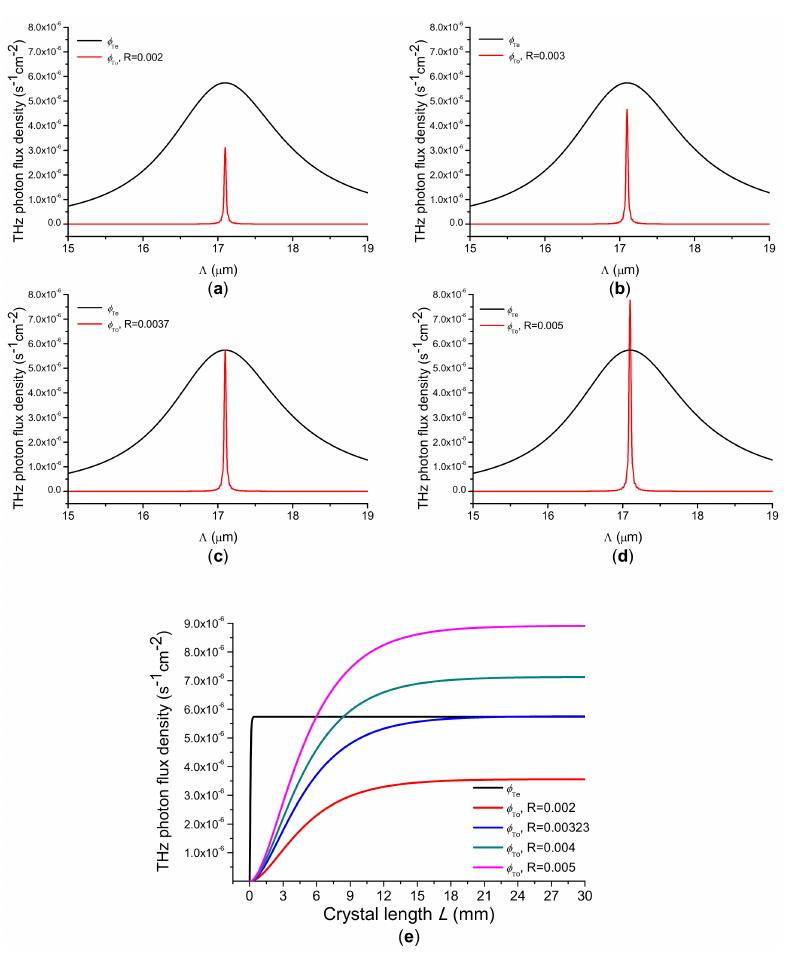
Figure 5. THz wave photon flux density φ T for the forward SPS processes. λ p = 1550 nm, ν Te = 4.66 THz, ν To = 0.56 THz, I p = 100 MW/cm 2 , and φ se ( 0 ) = 10 6 s − 1 cm − 2 . ( a – d ) φ T versus Λ with R = 0.002, 0.003, 0.0037, and 0.005, respectively. L = 10 mm. ( e ) φ T versus crystal length L . Λ = 17.0982 µ m.